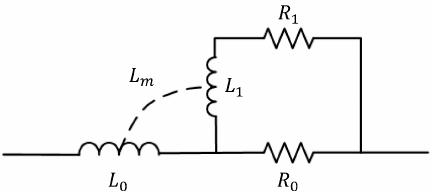
Figure 2. The ladder circuit representing the series resistance and inductance.